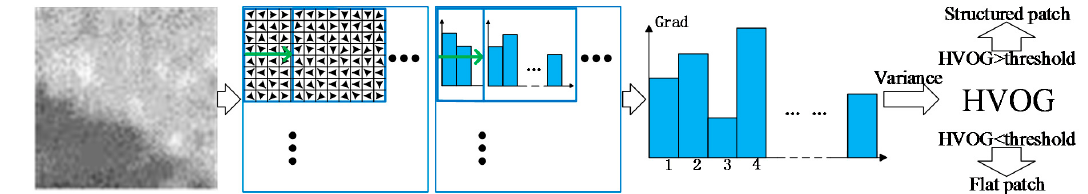
Figure 3. The patch classification process.